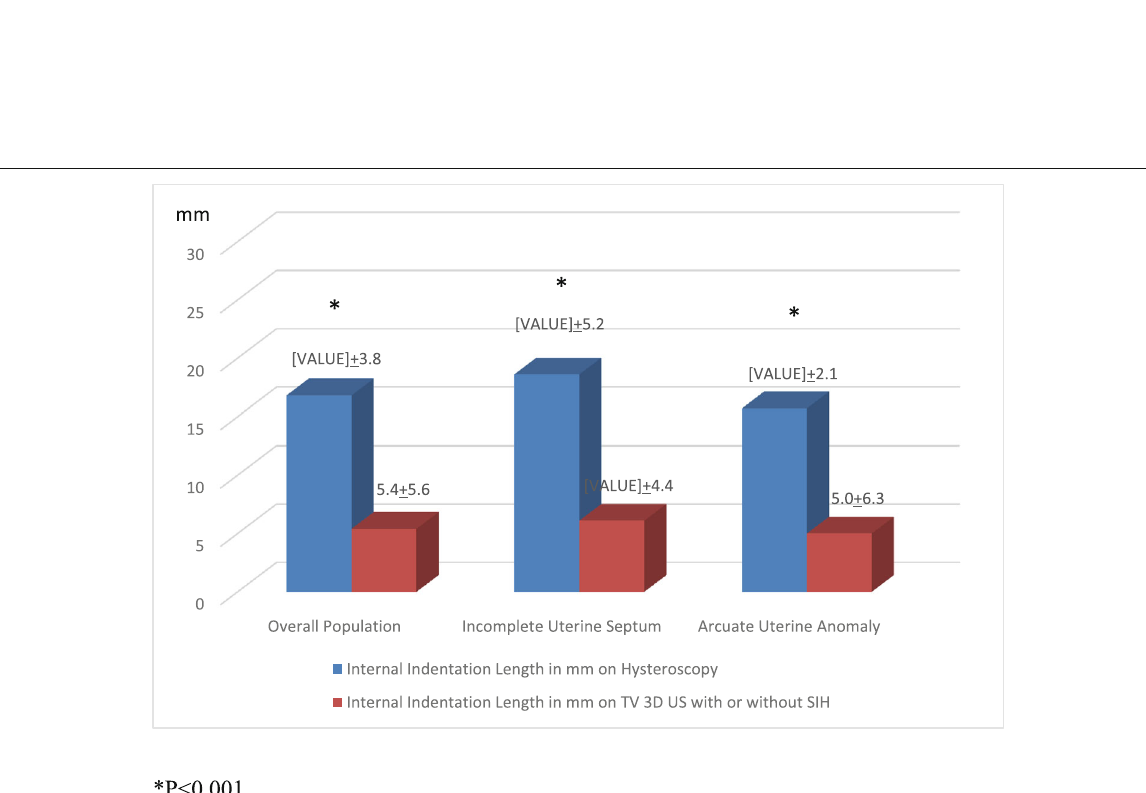
Fig. 6 Comparison between the mean IILFM measured in mm on hysteroscopy and on TV 3D US with or without SIH, in patients with IUS, significant AUA, and in the overall population in patients with significant internal indentation length ( ≥ 15